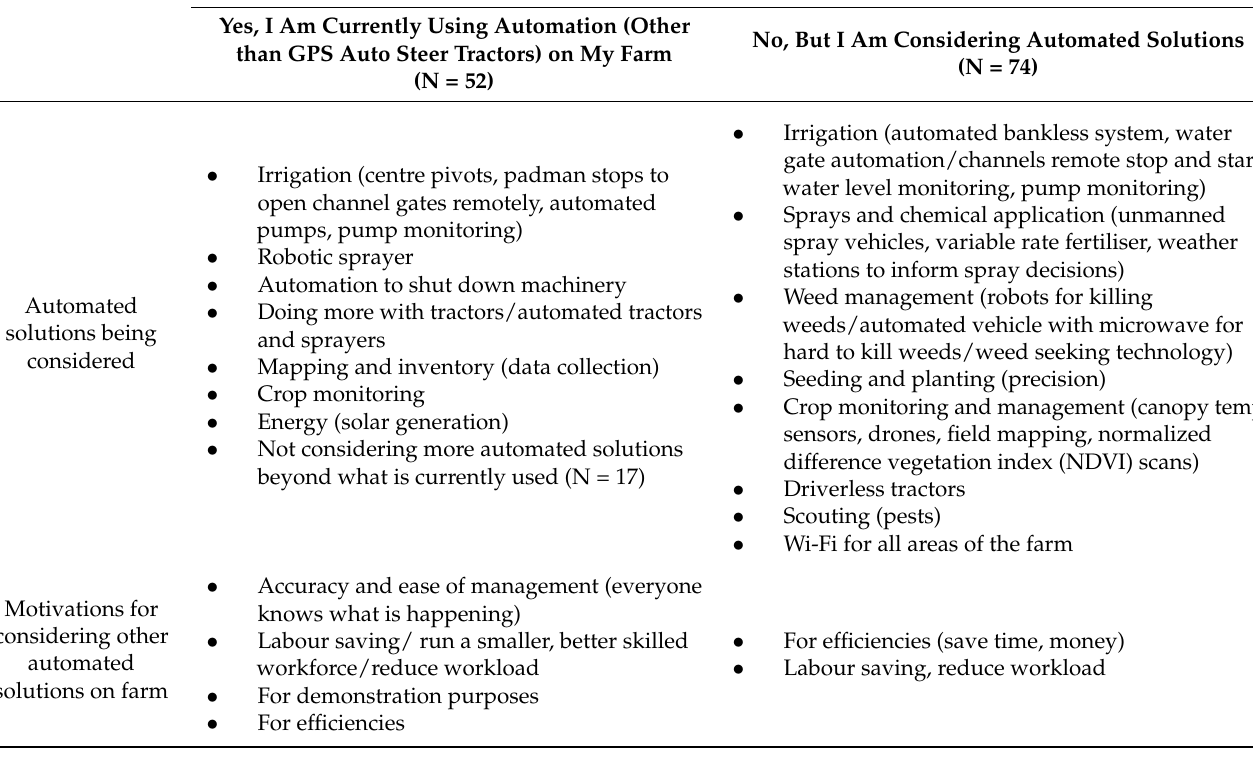
Table 1. Comparison of growers currently using automated solutions and those who are considering automated solutions for type of technology and motivation to adopt.